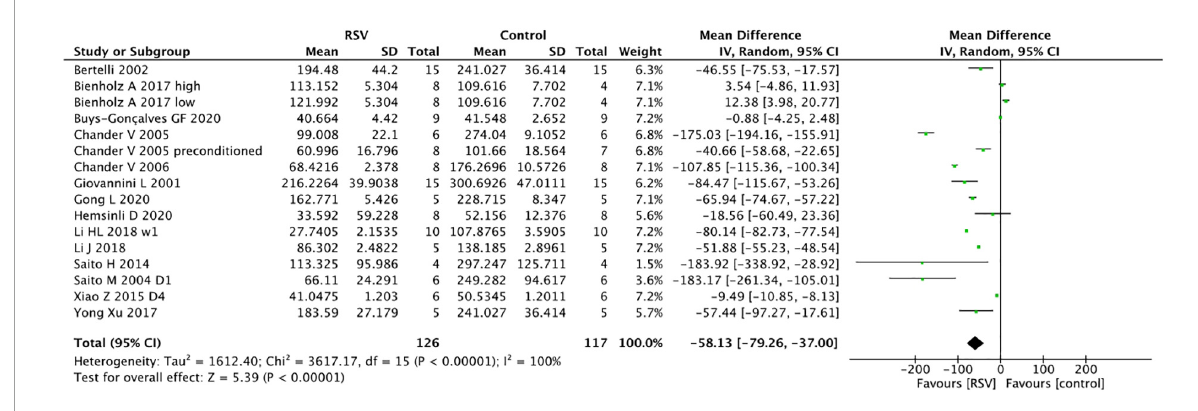
FIGURE2 Forest plot for the effects of resveratrol on serum creatinine.